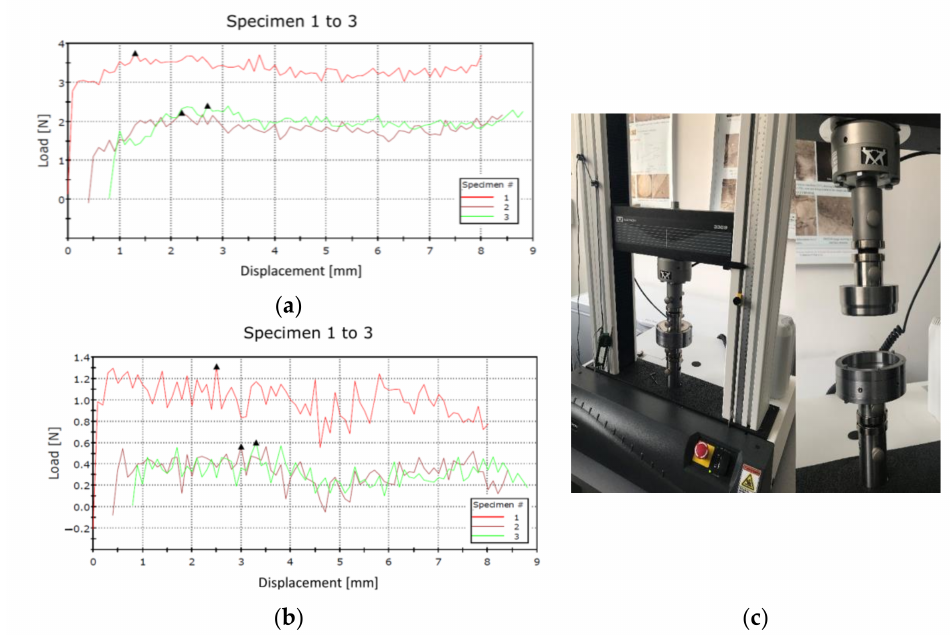
Figure 13. Empty tests results at: ( a ) the start of the testing campaign, ( b ) the end of the testing campaign) and ( c ) “empty test” set-up.